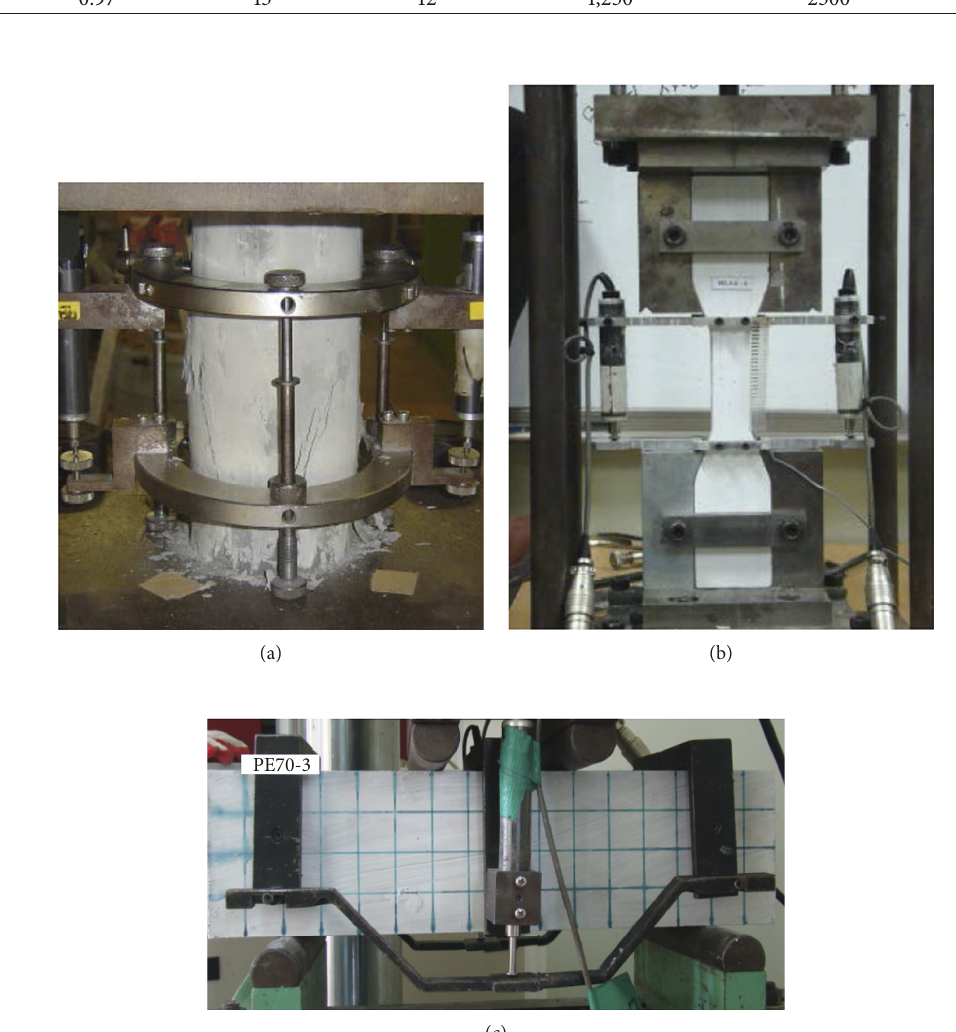
Figure 1: Test setups for mechanical properties. (a) Compression test. (b) Direct tensile test. (c) Flexural test.